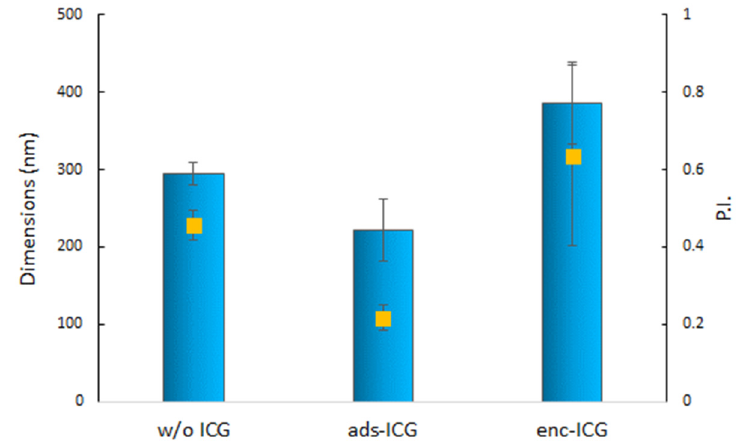
Figure 2. Dimensions and polydispersion index (PI square yellow symbols) of RSV-loaded NPs without ICG (w/o ICG) and with ICG associated by adsorption (ads-ICG) and by encapsulation (enc-ICG) (mean values n = 3 ± s.d.) .